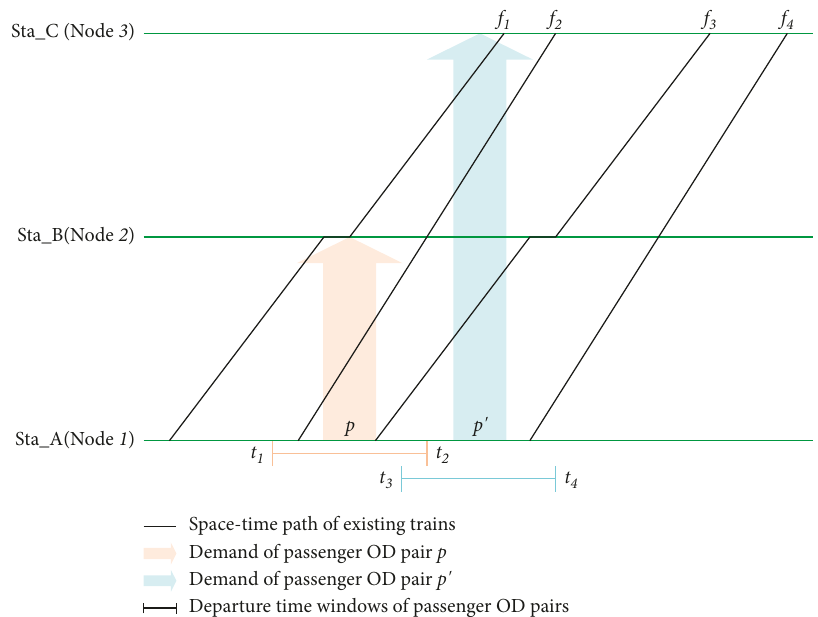
Figure 1: An illustration of the primary problem in the time-space network.